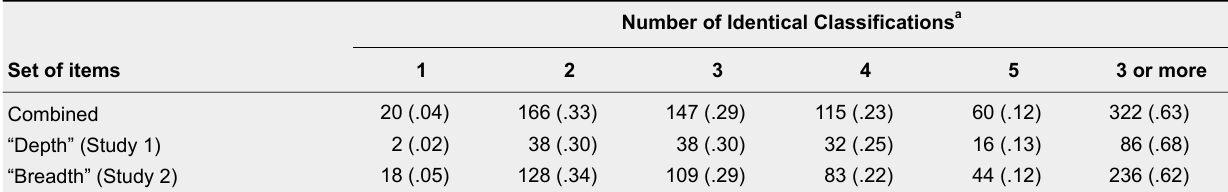
Consistency of Participants’ Classifications of Content Into Hypotheses (From the Full Set of 38 Candidates) in Study 2